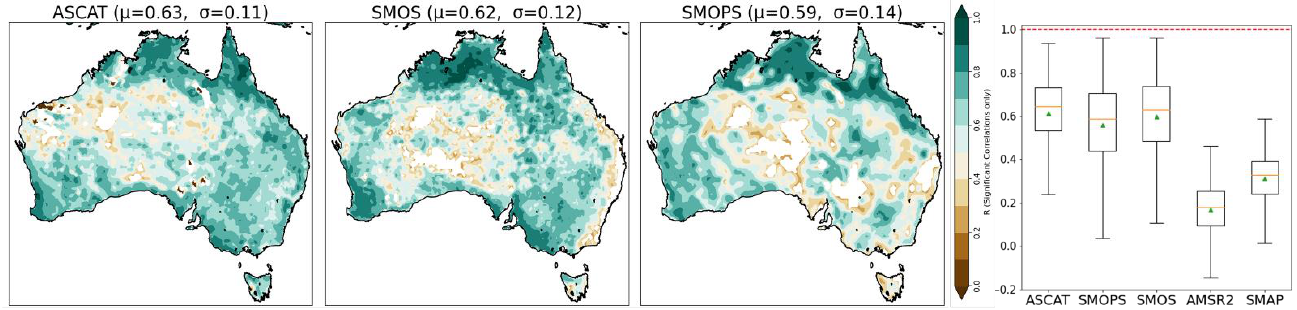
Figure 10. Temporal correlation coefficient results depicted spatially for ASCAT, SMOPS, SMOS, AMSR-2, and SMAP. An accompanying box-whisker plot depicts the spatio-temporal results— whiskers extend out to show the interquartile range, the orange line indicates the distribution median, and the green triangle indicates the distribution mean, red dashed line indicates perfect value.